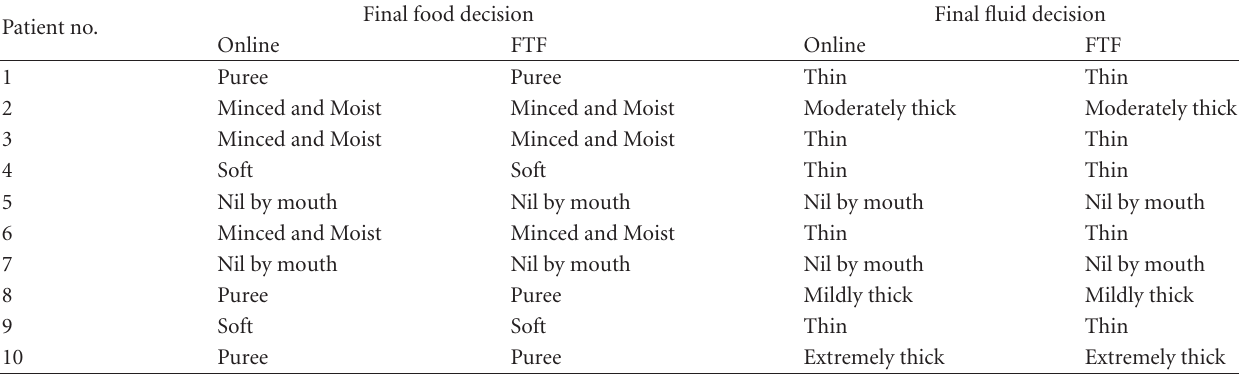
Table 2: Clinical decisions on safe food and food and fluid consistencies for each patient as made during simultaneous assessment by the online and face to face clinician. Patient